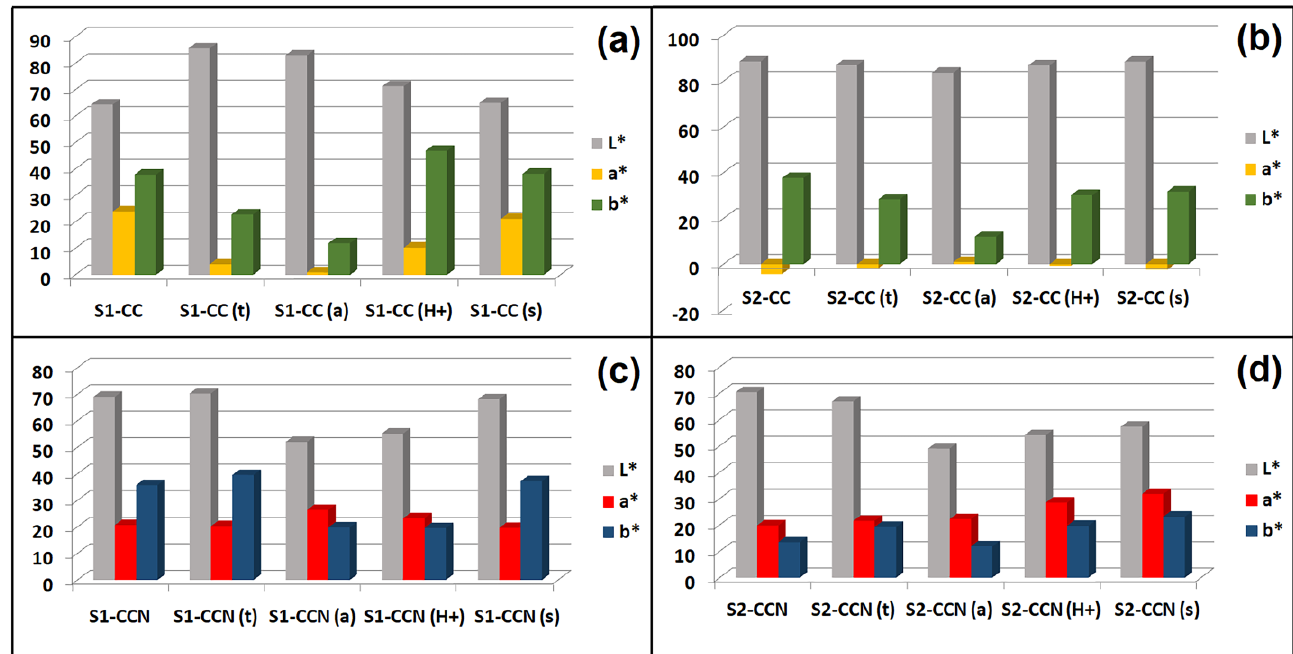
Figure 9. Color parameters in the CIELAB system for colored nanocomposites (S1-CC ( a ), S2-CC ( b ), S1-CCN ( c ), S2-CCN ( d )) and after testing their resistance to low temperature (t), alkaline (a), acid (H+) and saline (s) solutions.